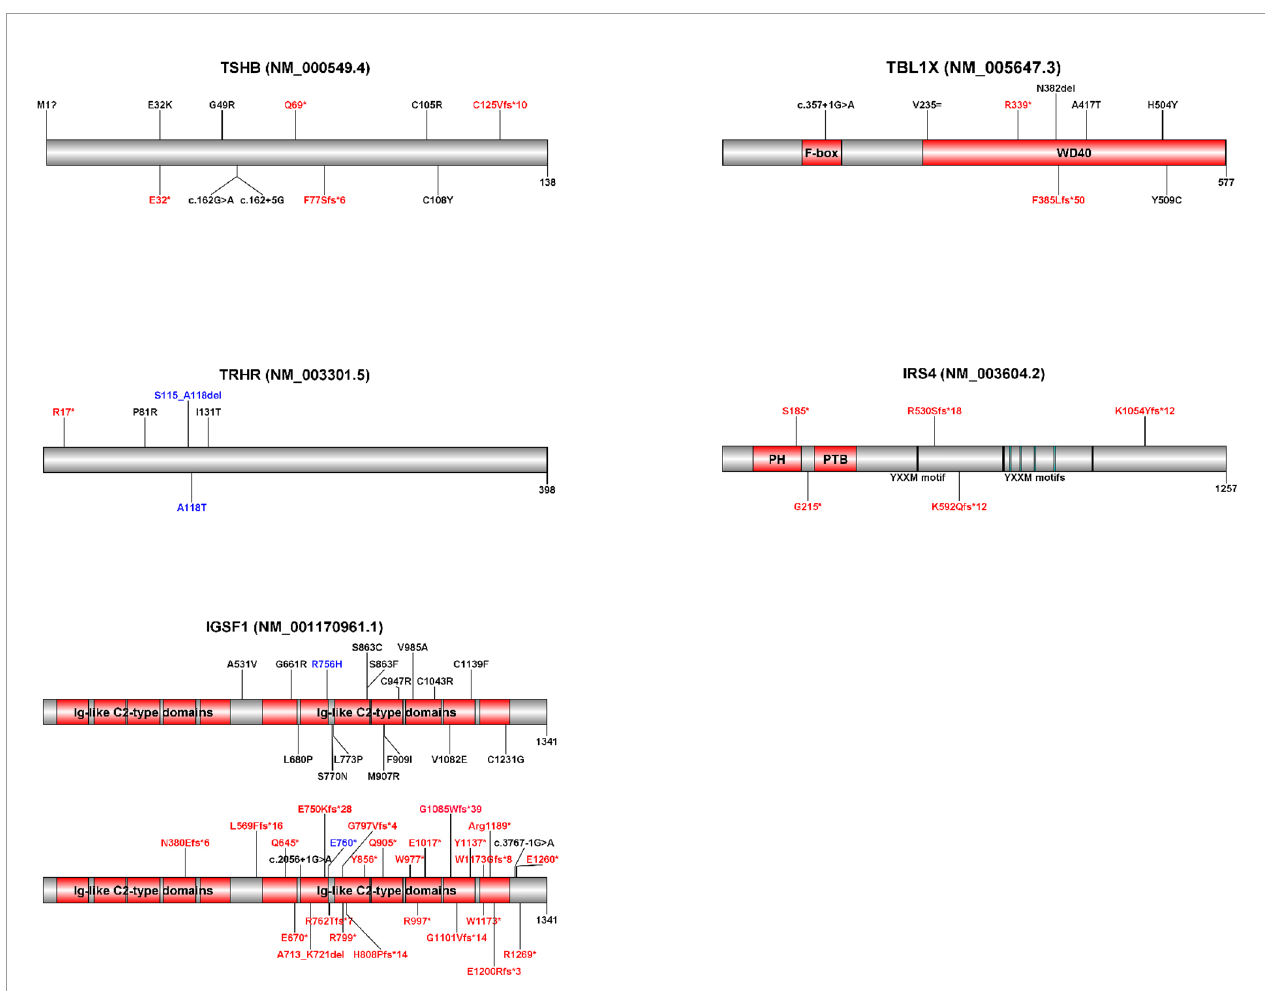
FIGURE 2 | Schematic representations of the fi ve genes implicated in isolated central CH with known pathogenic variants. Variants displayed in red represent premature termination codon variants. Variants displayed in black represent missense, synonymous and in-frame indel variants. Variants displayed in blue were found on the same allele. Variant annotations may differ from published variants due to differences between transcripts (indicated in brackets). Diagrams were created with Domain Graph, version 2.0 (http://dog.biocuckoo.org/). Ig, immunoglobulin; PH, pleckstrin homology domain; PTB, phosphotyrosine binding